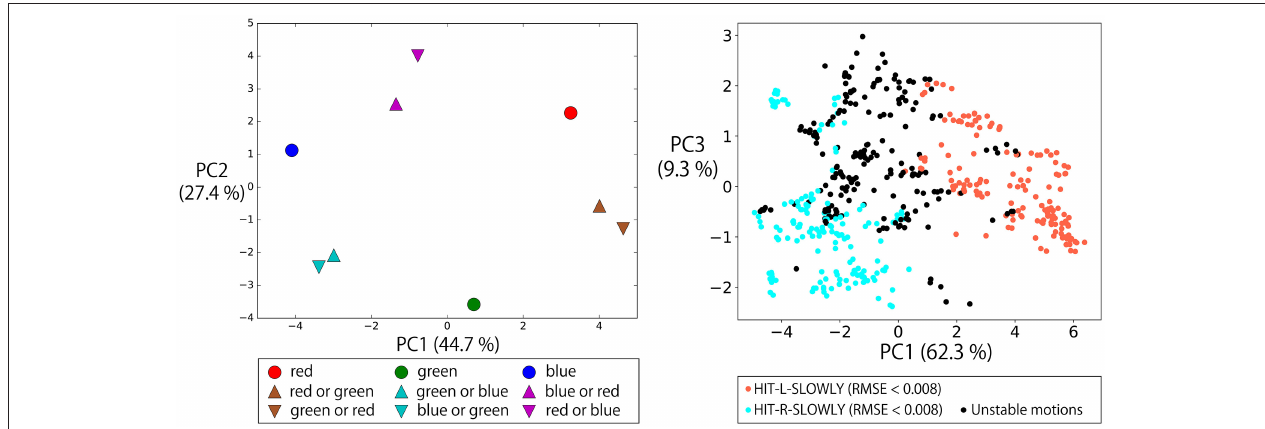
FIGURE 14 | Left : The states of the memory cells after giving instructions in the form of “hit (objective part) slowly” that include one objective word or two OR-concatenated objective words. The activations after the OR-concatenated instructions are located between the activations for the one objective word instructions. For example, “hit red or green slowly” and “hit green or red slowly” are embedded between the encodings of “hit red slowly” and “hit green slowly.” Right : To a robot waiting with bells arranged in the order of RGB from left to right after 2,048 different contexts, we gave the instruction “hit red or blue slowly.” The memory cell states after the instruction were arranged on an arch shaped space which was less defined than that for the flag task. When the activation was on the left side of the arch, the robot generated HIT-L-SLOWLY action. For activation on the right side, the robot generated HIT-R-SLOWLY action. When the activation was in the topmost area, an unstable action was generated.